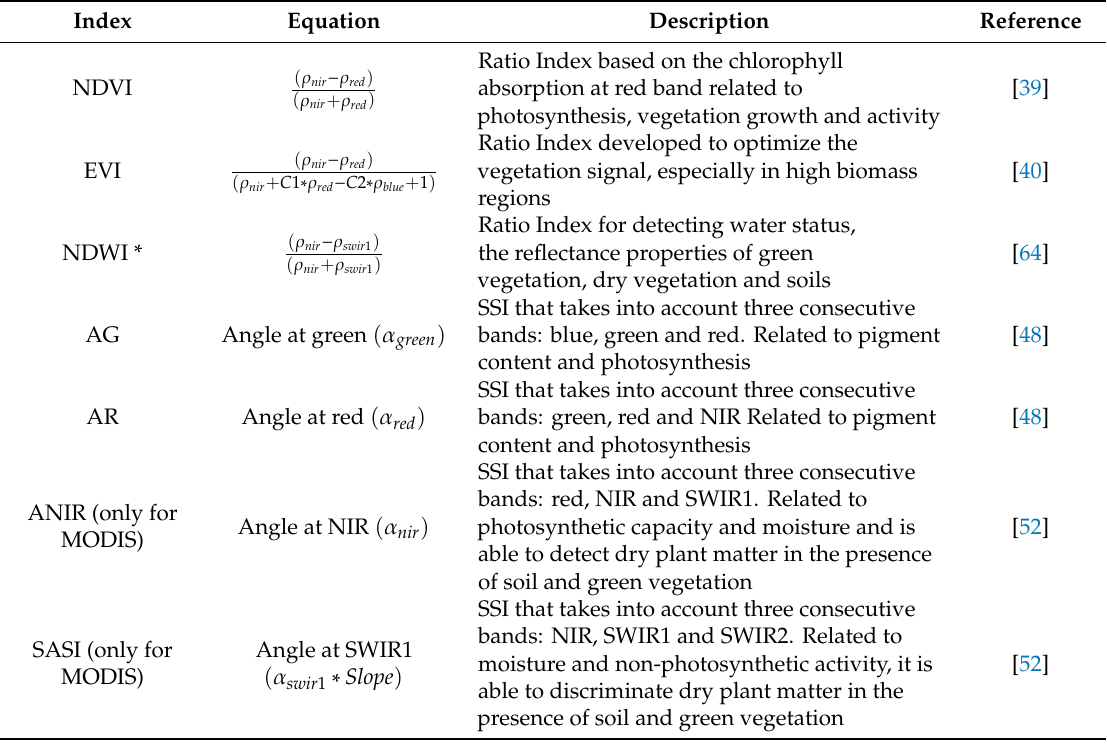
Table 2. Spectral indices obtained based on MODIS and Sentinel-2